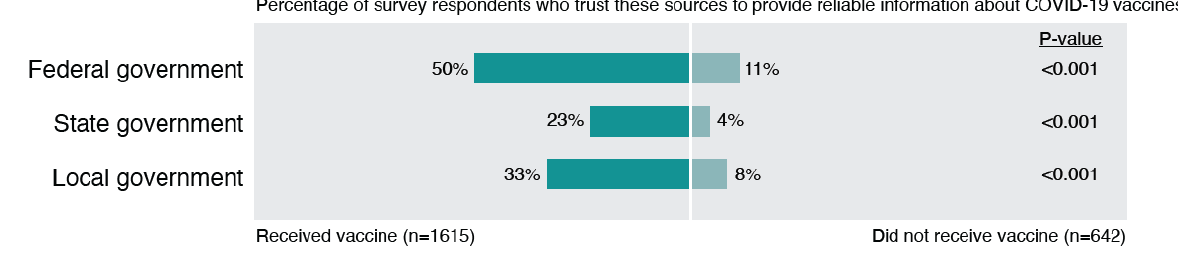
Figure 1. Differences in trust in government between vaccinated and unvaccinated EMS profession- als.